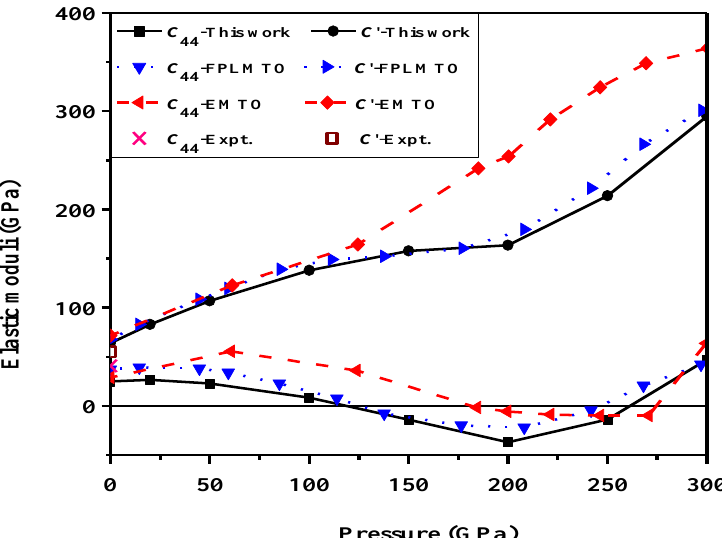
Figure 7. Calculated elastic moduli of BCC vanadium as a function of pressure. (By the courtesy of Ref. [54]).